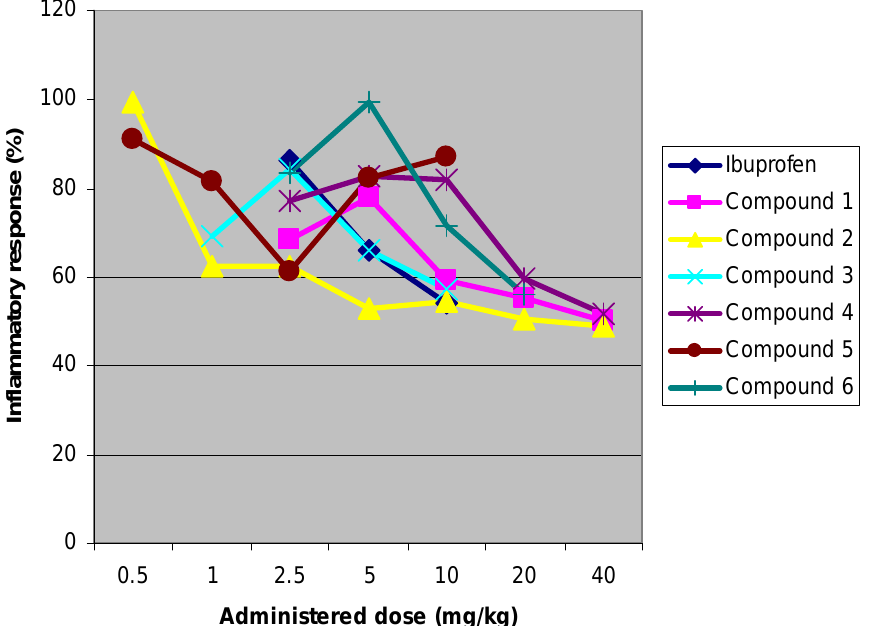
Figure 2 . Dose dependence of anti-inflammatory effects of the studied compounds listed in the